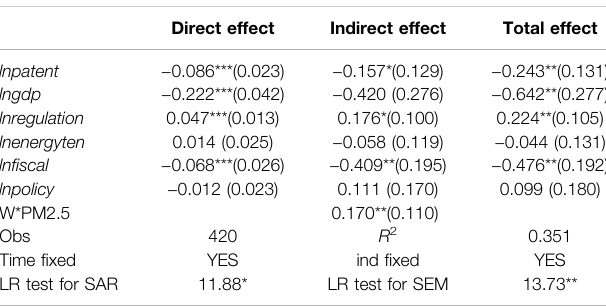
TABLE 7 | Estimation results of Spatial Durbin